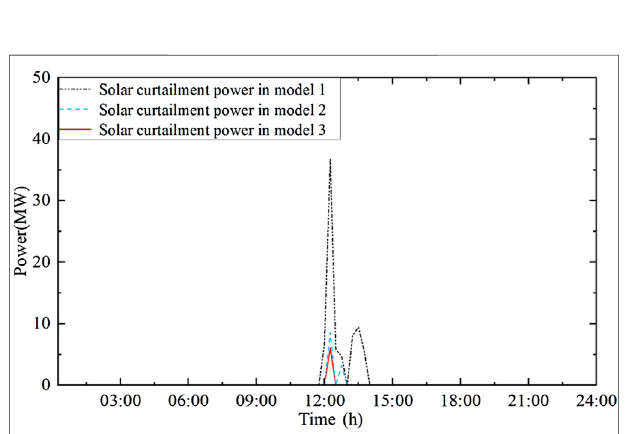
Model 1: The traditional day-ahead scheduling model is adopted for the renewable energy regional power grid, and the joint optimal scheduling of the ESS and CSP plant is not considered.